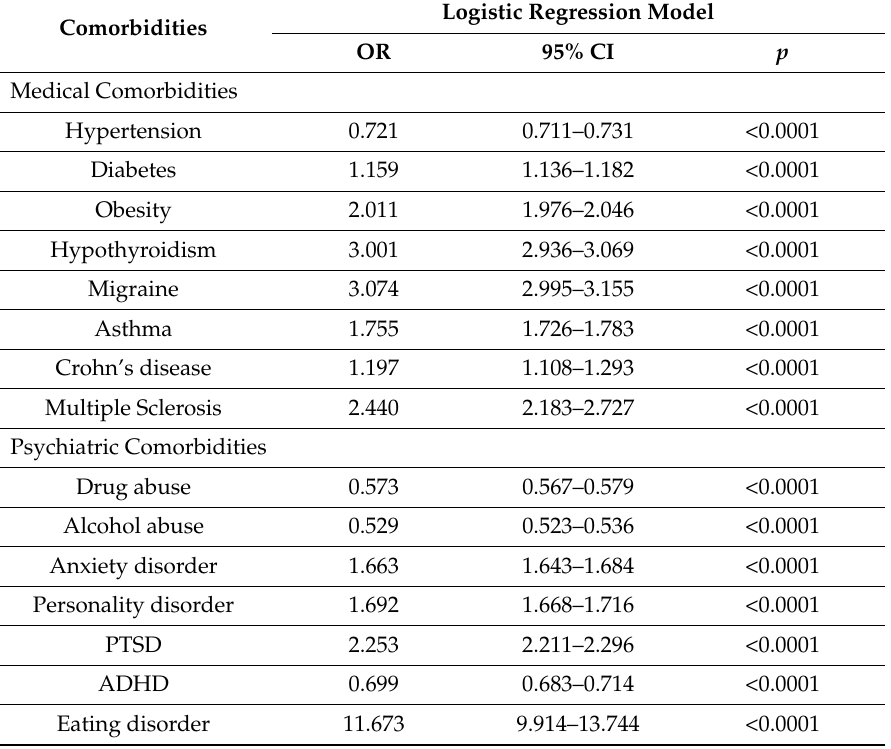
Table 2. Odds of medical and psychiatric comorbidities with bipolar disorder in females compared with